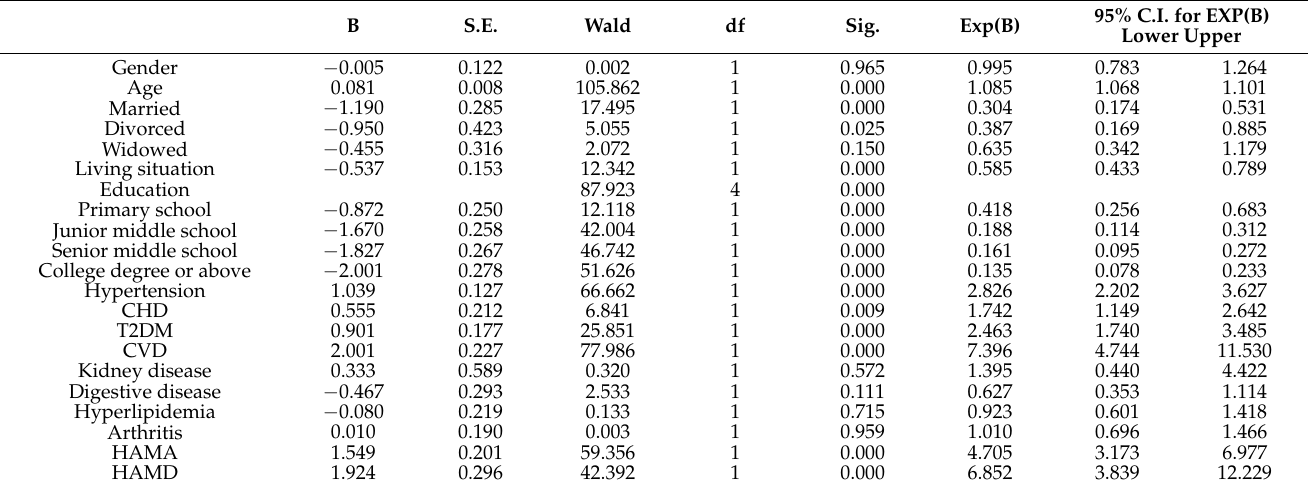
Table 6. Univariate logistic regression analysis of the risk factors for senile